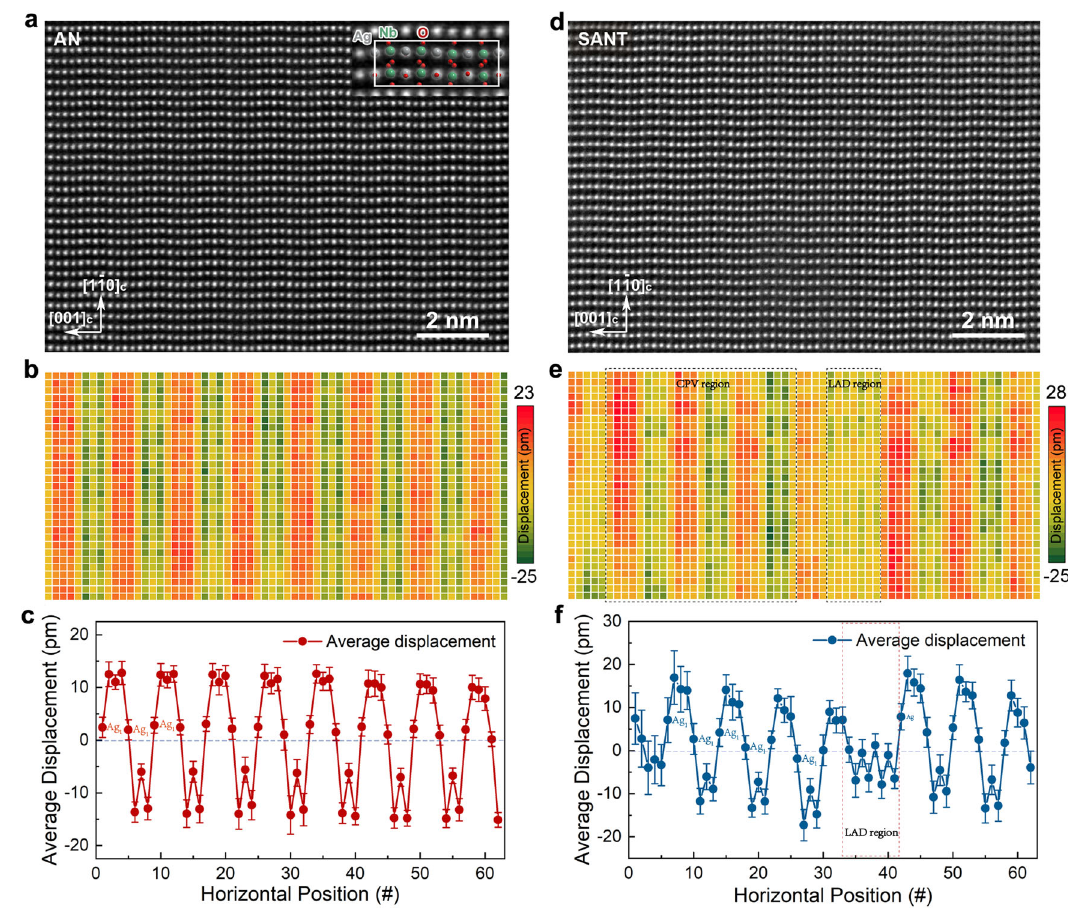
Fig. 2 | Comparison of the atomic-scale structures of AN and SANT. HAADF- STEM image of pure AN. Inset shows the local enlargement with the crystal struc- ture overlaid ( a ). Map of the atomic displacements of Ag and Nb atoms along the ± ½ 1 (cid:1) 10 (cid:2) c direction, showing a good c -axial periodicity ( b ). Average displacement of each vertical atomicplane ( c ).HAADF-STEM image of SANT ( d ).Mapof the atomic displacements of Ag, Nb, and Ta atoms along the [1-10] C direction ( e ). Both the